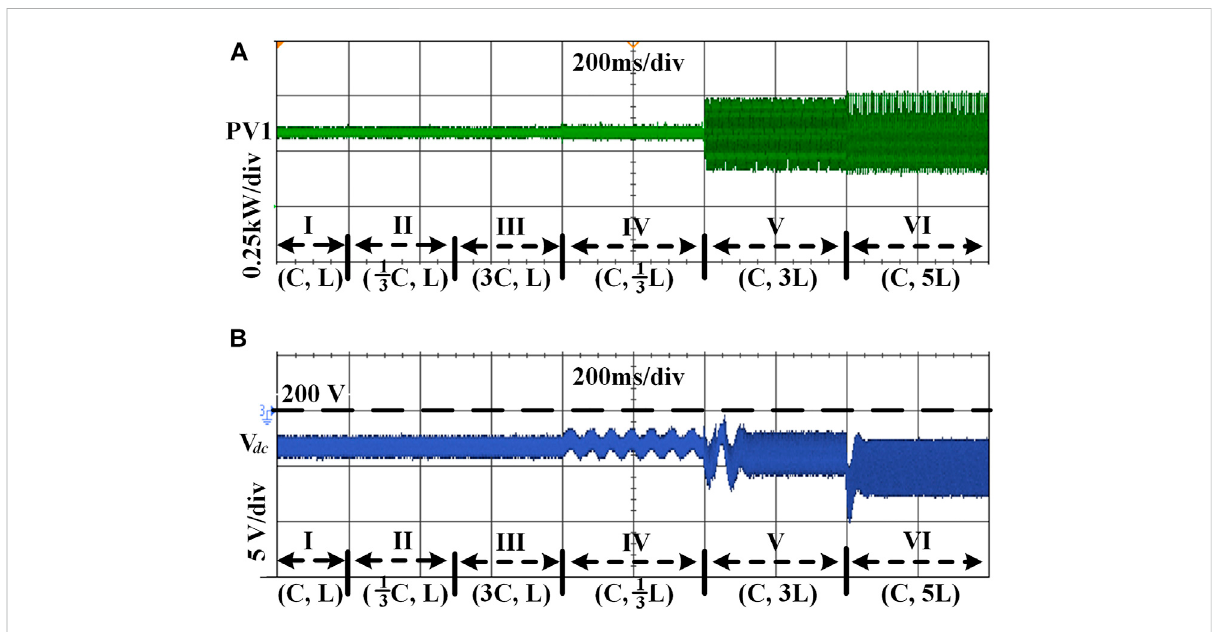
FIGURE 11 Robustness test with model parametermismatches. (A) Power output ofPV1 with mismatched C and L. (B) DC-bus voltage with mismatchedC and L.